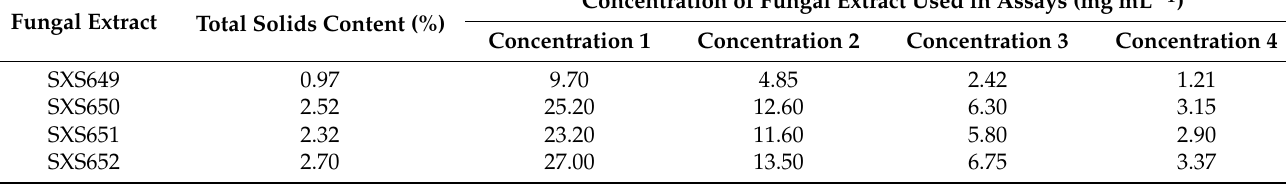
Table 1. Total concentration of solids content of fungal extracts and standardization of concentrations to assess antioxidant, antimicrobial, antitumor and toxicity activities. Fungal